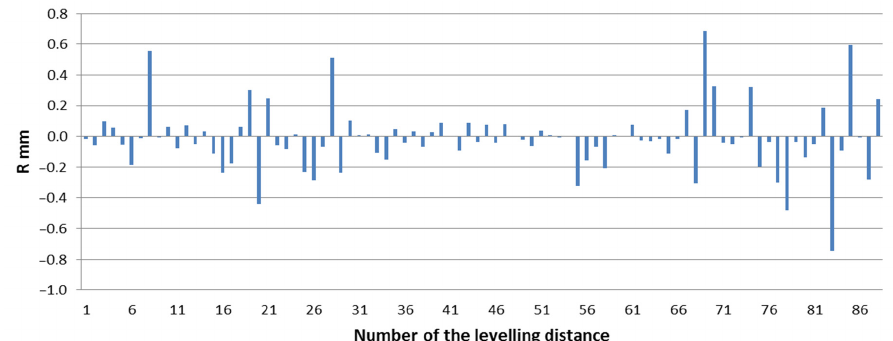
Figure 5. Refraction correction values for every leveling distance in back